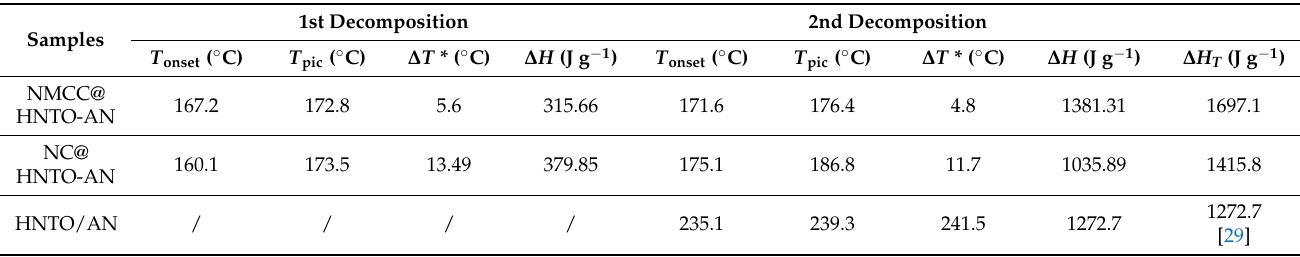
Table 1. DSC data of the designed energetic formulations determined at β = 10 ◦